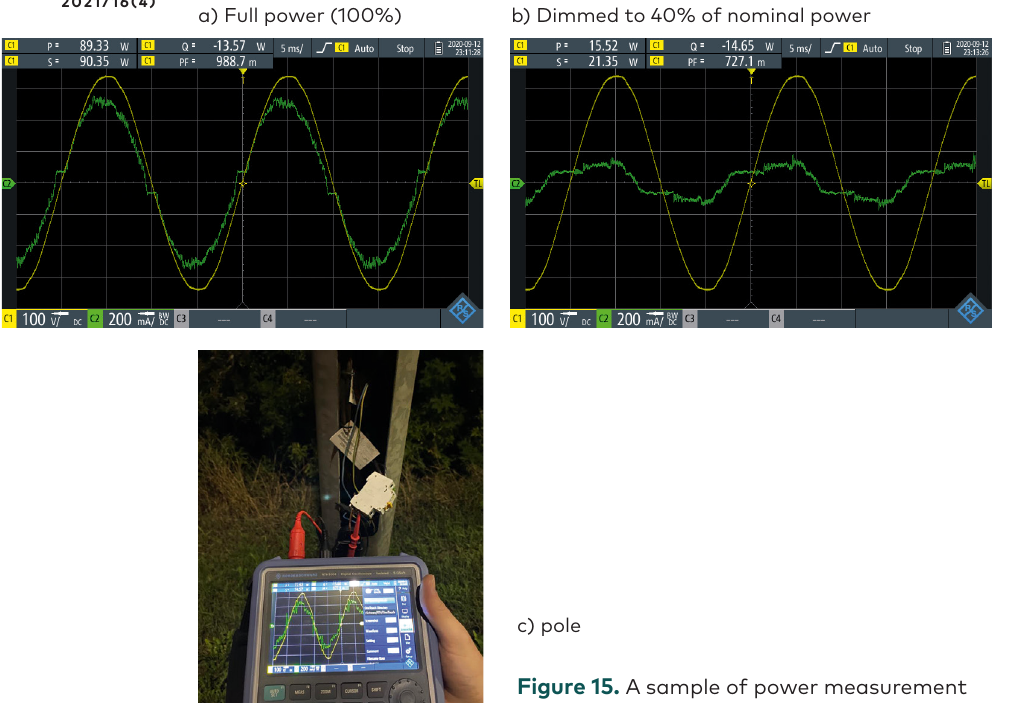
Figure 15. A sample of power measurement waveforms of 86W LED